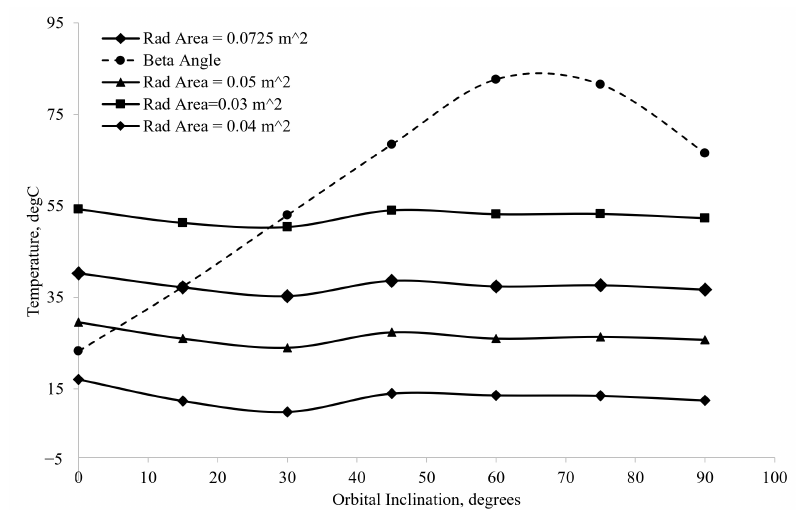
Figure 22. BMR temperature variation with inclination and beta angle—Worst hot condition.